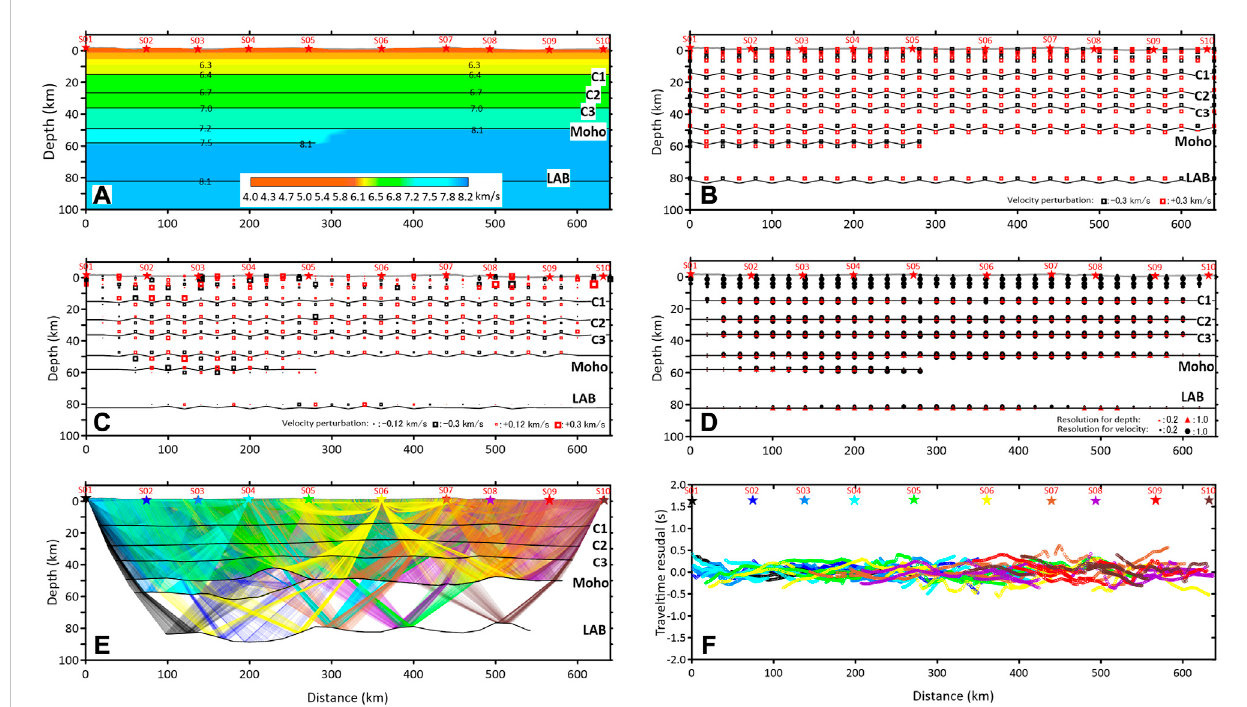
FIGURE 4 Reliabilityassessmentofthe fi nalseismicvelocitymodel. (A) :theinitialhomogeniousvelocitymodel; (B) .thevelocityanddepthperturbationmodel, forwhichthepositiveandnegativevelocityperturbationof0.3 km/sarealternativelyaddedtothevelocitynodesontheinitialmodel,andmeanwhilethe depth perturbation of 1.0 km are alternatively added to the depth nodes on the initial model; (C) . the recovered velocity and depth perturbation model; (D) . the diagonal elements of resolution matrix for the depth and velocity nodes, where the red triangle indicate the element for depth node, while the black dot indicate the element for velocity node; (E) . the ray-path coverage for different shot points; (F) . the time-residuals for different shot